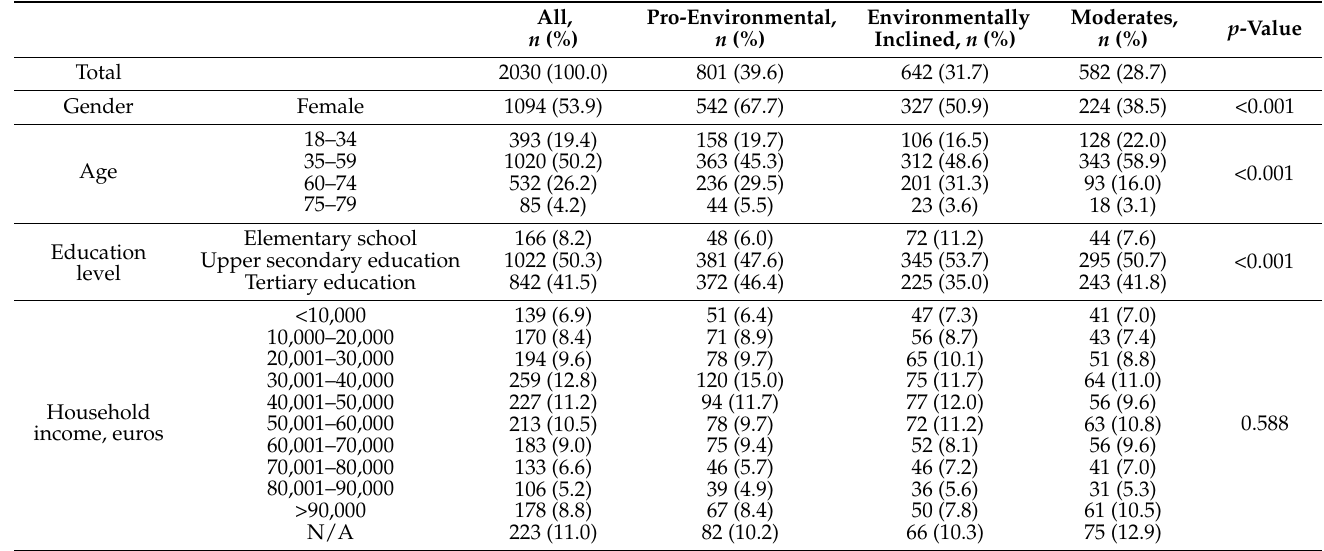
Table 3. Sociodemographics of the respondents and their environmental-attitude-based latent classes. All, n